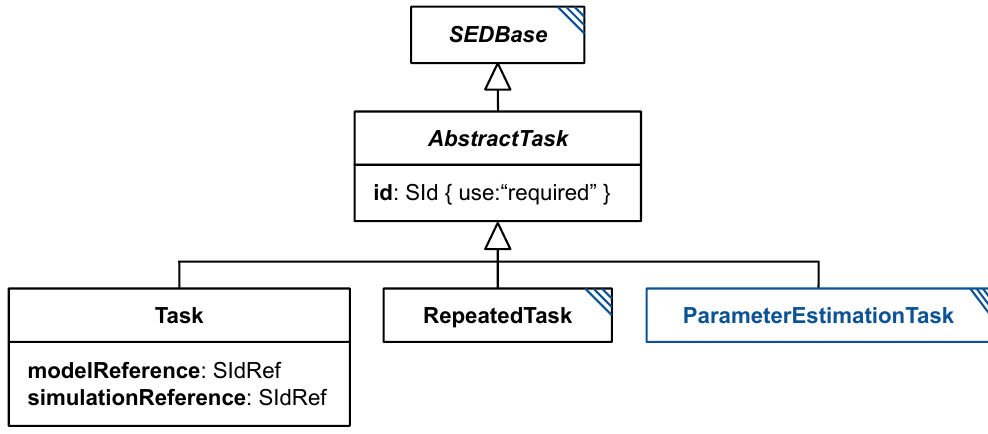
Figure 2.12: The SED-ML AbstractTask and Task classes. The RepeatedTask and ParameterEstima- tionTask classes are defined